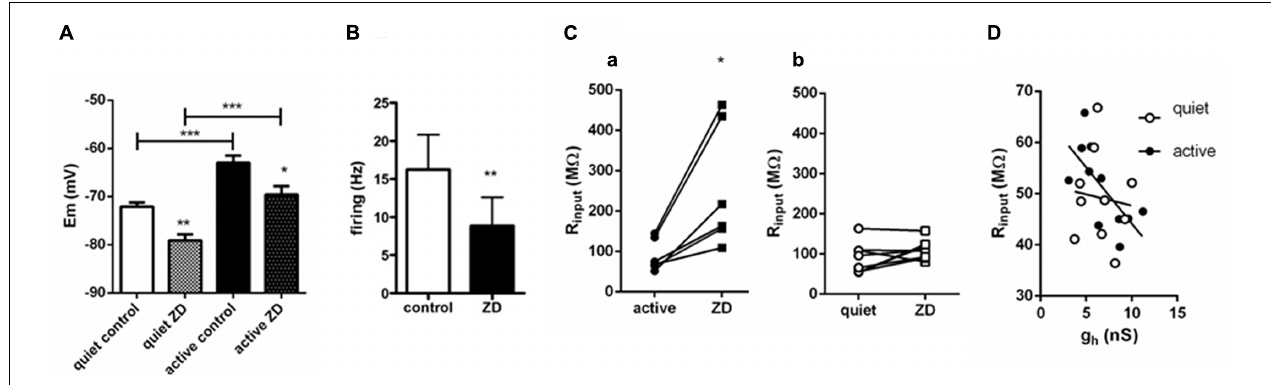
FIGURE 4 | Influence of I h on RMP, firing and input resistance of quiet and active fusiform neurons. (A) Effects of ZD 7288 (20 µ M) on the RMP of quiet and active fusiform neurons. ∗∗ p < 0.01; paired t -test (compared with active control) and unpaired t -test (compared quiet and active ZD); ∗∗∗ p < 0.001, paired t -test (compared with quiet control). (B) Summary of the effect of ZD 7288 on the intrinsic firing of fusiform active neurons. ∗∗ p < 0.01, paired t -test. (C) Effect of blocking I h with ZD7288 on the membrane input resistance measured in voltage-clamp in quiet (a) and active (b) DCN fusiform neurons. ∗ p < 0.05, paired t -test. (D) Change of membrane input resistance produced by ZD7288 in quiet ( n = 10) and active neurons ( n = 7). ∗∗ p < 0.01, unpaired t -test. (E) Correlation of membrane input resistance with g h conductance of quiet and active